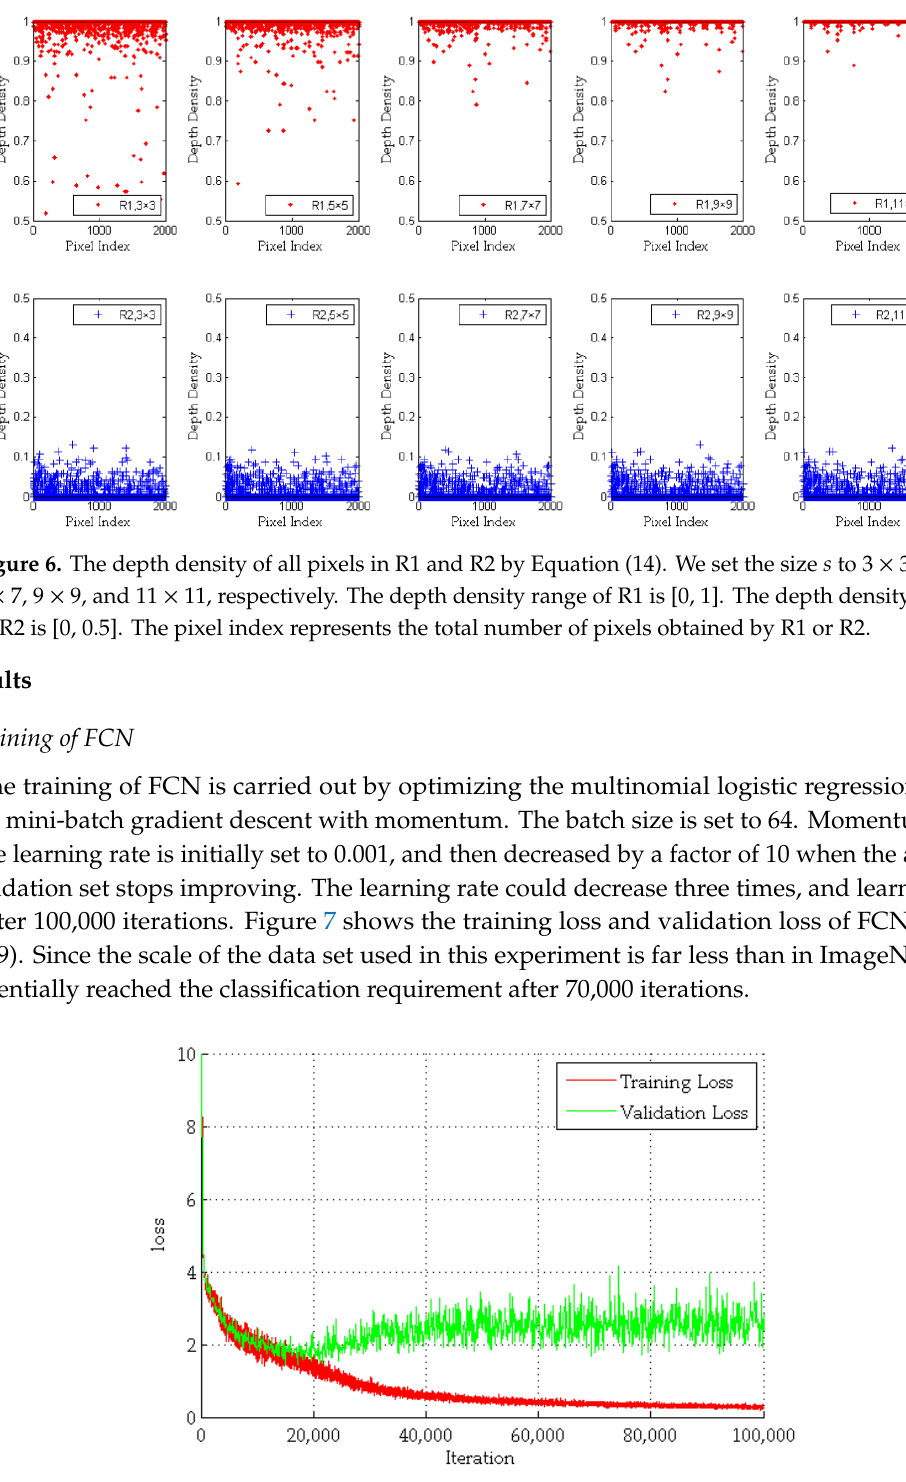
Figure 7. The losses of training and validation with FCN (fully convolutional networks). The abscissa represents the number of training batches. The ordinate represents the value of training or validation loss.